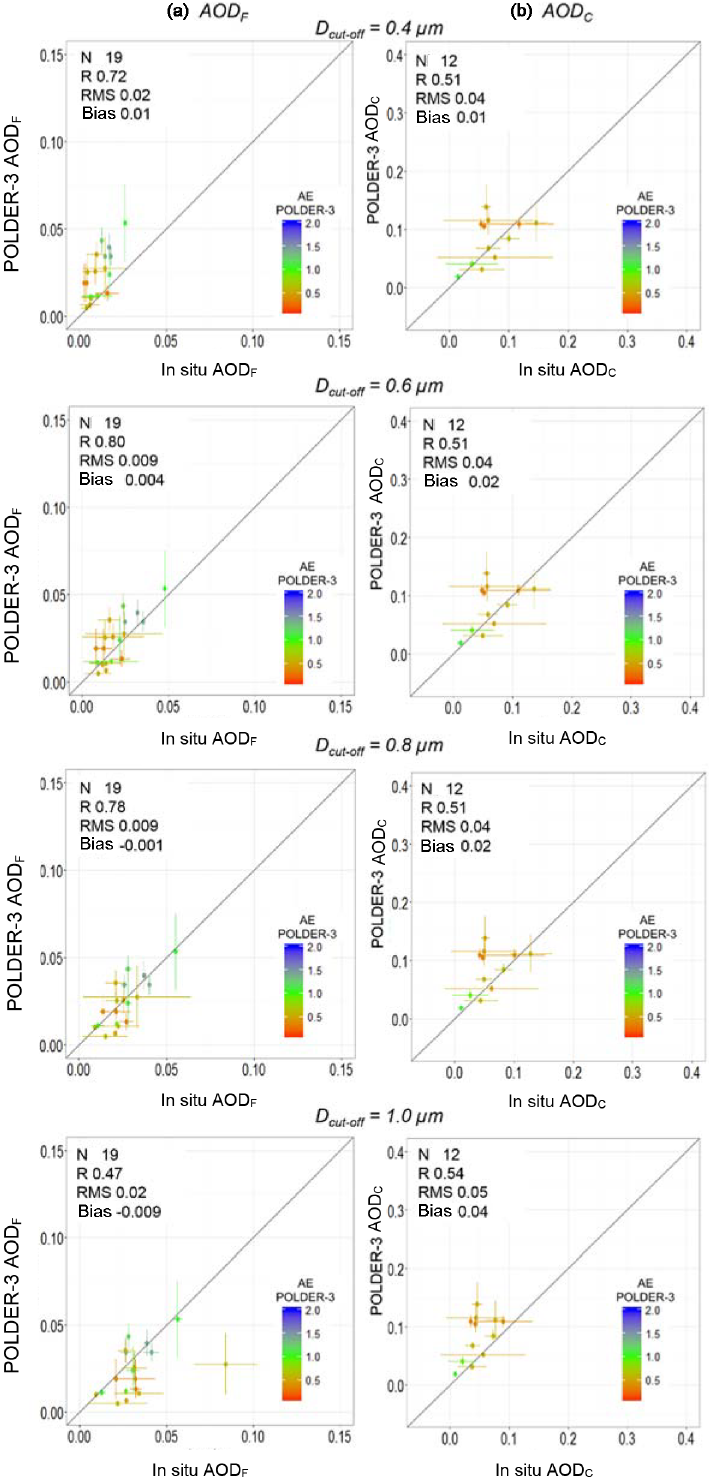
Figure 6. Scatter plots of AOD F (a) and AOD C (b) retrieved by POLDER-3 at 865nm and compared to values obtained by optical calcula- tions from airborne measurements of the number size distribution. Panels, from top to bottom, represent the results of the calculations when varying the cut-off diameter between 0.4 and 1.0µm. Characteristics of the linear correlation are also reported (number of points N , corre- lation coefficient R , RMSE, and bias). Error bars of in situ measurements were calculated from the optical calculation and the instrumental uncertainties. The solid line is the